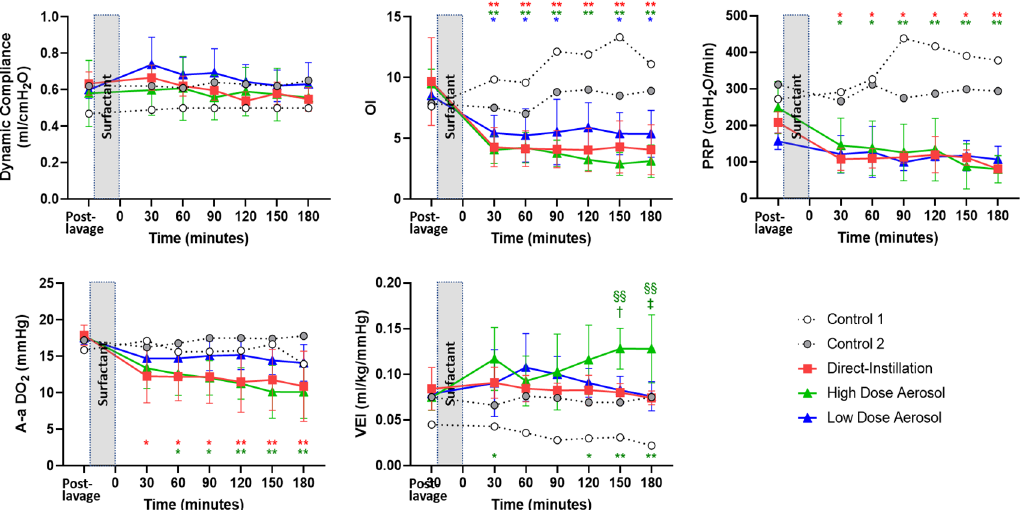
Figure 4. Disease Severity and Effort of Breathing. Physiologic data are represented as individual data for Control and mean ± SD for Surfactant treatment groups during the 180 min treatment period. The post-lavage condition shows animals following lung injury and stabilization and represents the baseline pre-treatment condition and the time at which treatment was instituted. Time point 0 represents timepoint following completion of surfactant administration. The time increments represent values obtained 30 min after completion of treatment and at 30 min intervals thereafter. Dynamic compliance was not different between groups or from baseline following treatment. All treatment groups had improved OI, with significant reductions post-treatment when compared to respective baseline condition; whereas OI in Controls remained increased throughout the 3 h. High Dose Aerosol had greater VEI than all treatment groups at 150- and 180 min following surfactant replacement therapy and at 30, 150, and 180 min when compared to baseline condition. High Dose Aerosol and Direct-Instillation groups had lower A-a DO 2 and PRP post-treatment treatment when compared to baseline but Low Dose Aerosol did not. There were no differences in OI, PRP, and A-aDO 2 between groups at any timepoint following treatment. *, p < 0.05; **, p < 0.01 vs. baseline. †, p < 0.05; ‡, p < 0.01 vs. Low Dose Aerosol. §§, p < 0.01 vs. Direct-Instillation. OI, oxygenation index; VEI, ventilation efficiency index. A-a DO 2 , alveolar-arterial difference in oxygen tension; PRP, pressure rate product.